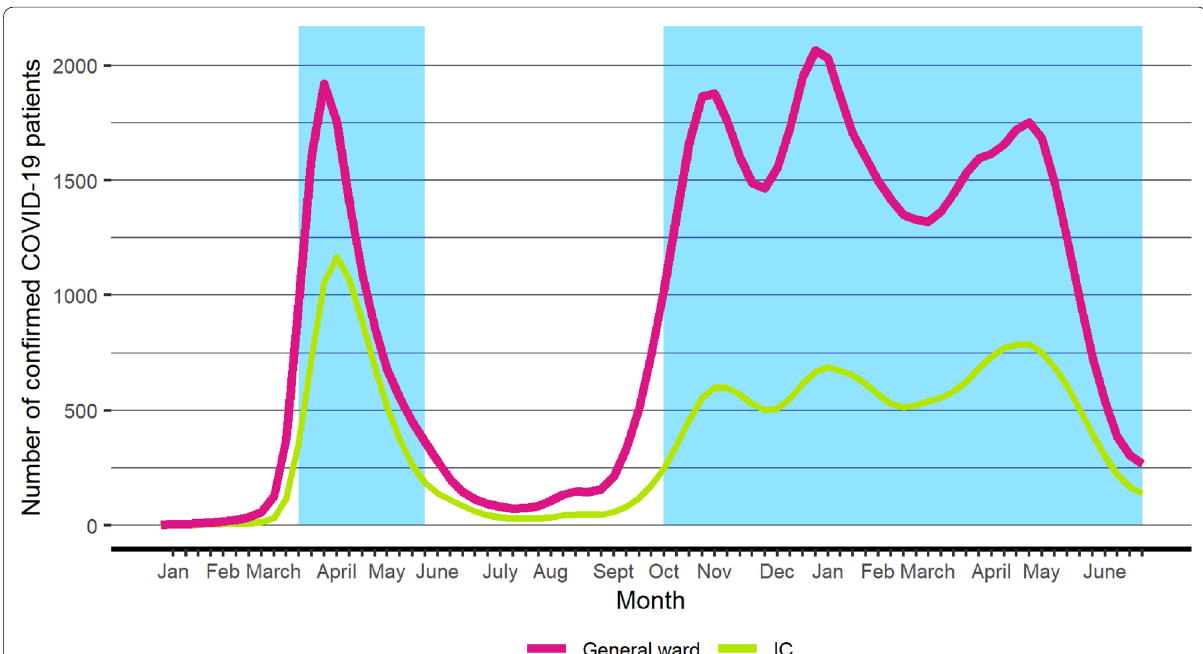
Fig. 1 Number of COVID‑19 patients present at the general ward in hospital and at the ICU during the pandemic in the